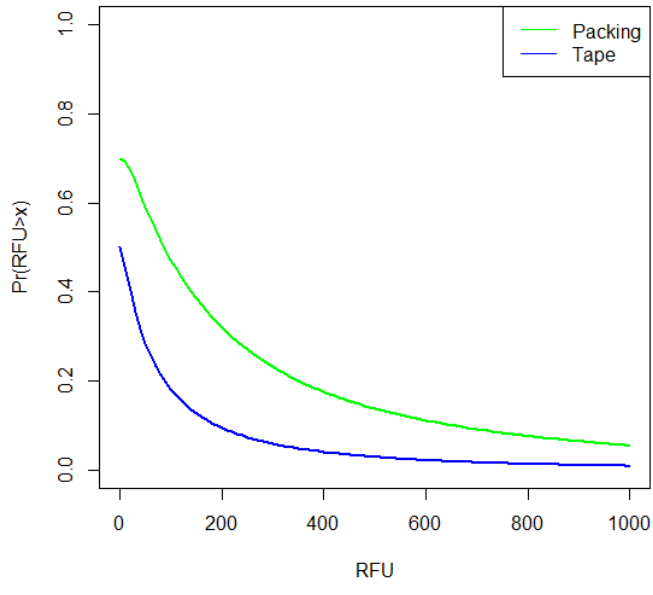
Figure 10. Lognormal distributions of RFU C 1 pack and RFU C 2 tape . Table 5. Relationship of probabilities of DNA transfer from individuals A and B, showing the datasets that were used to calculate probability distributions, along with the BN nodes instantiated. Nomenclature is described in Section 2.5.1.